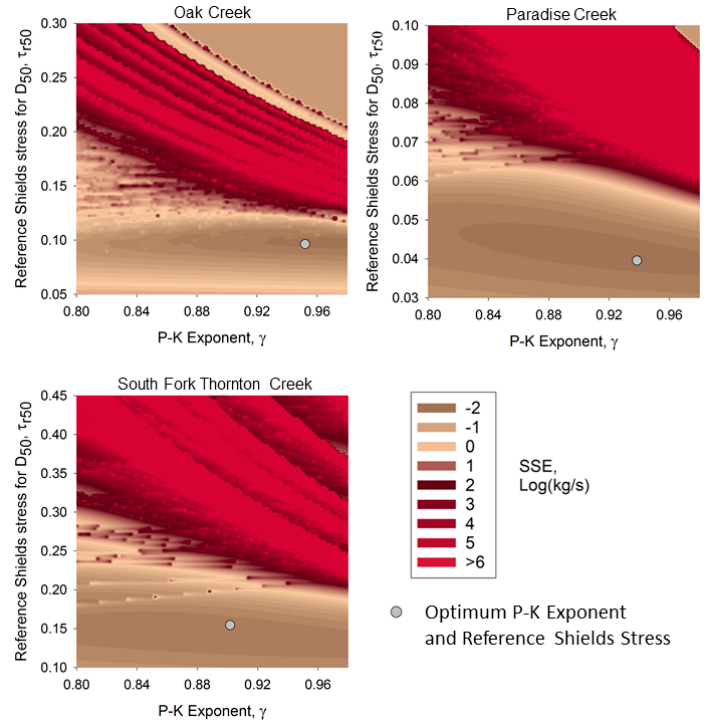
Figure 5. Average sum of squared error (SSE). SSE was computed by application of the Parker–Klingeman (1982) model to Oak Creek, Paradise Creek, and South Fork Thornton Creek for combinations of hiding factor reference Shields stress for D 50 and exponent (see Equation (1)) as shown. SSE is computed from all grain sizes, of all samples, in which both measured and computed load are non-zero. Values of optimum reference Shield stress and exponent are given in Table 1. Water 2017, 9, 441